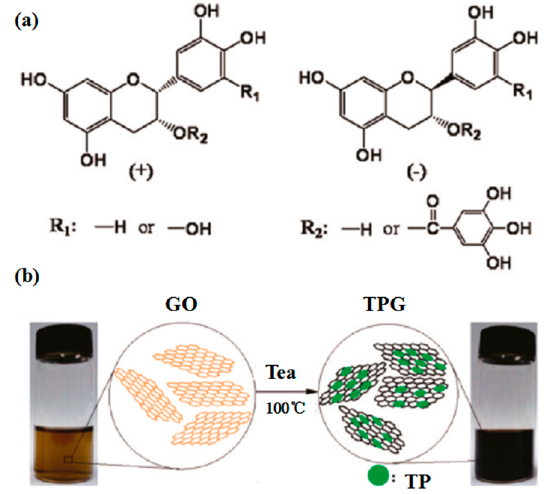
Figure 26. ( a ) Chemical structure of tea polyphenols (TPs). ( b ) Schematic illustration of the preparation of TP reduced graphene. Reproduced from [122]. Copyright American Chemical Society, 2011.